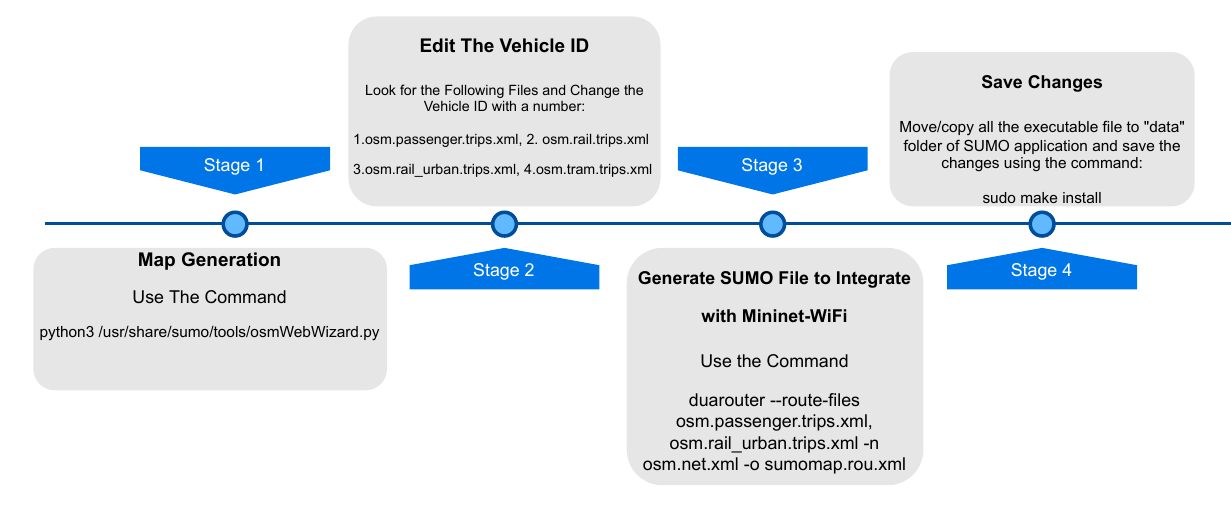
Figure 39. SUMO integration steps.